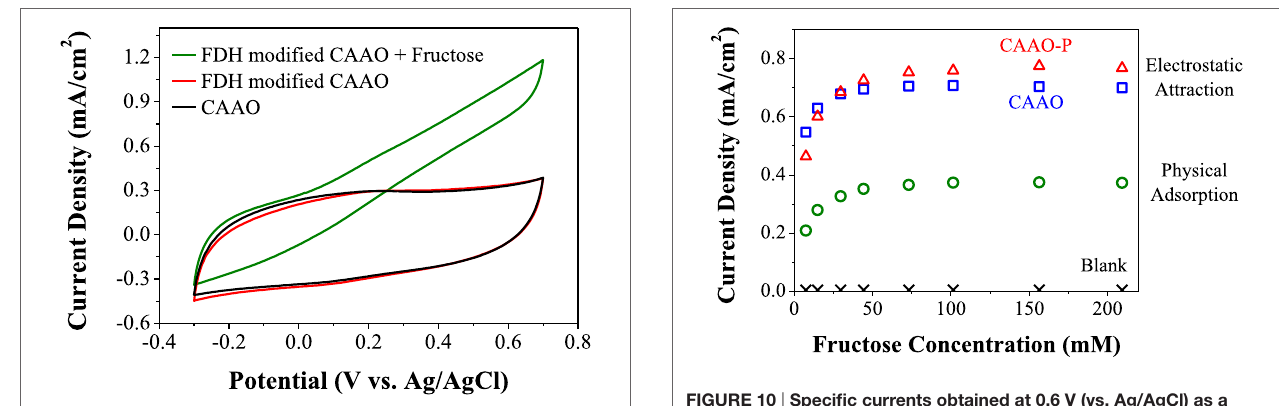
FigUre 10 | specific currents obtained at 0.6 V (vs. ag/agcl) as a function of fructose concentration for the three types of FDh- modified electrodes .